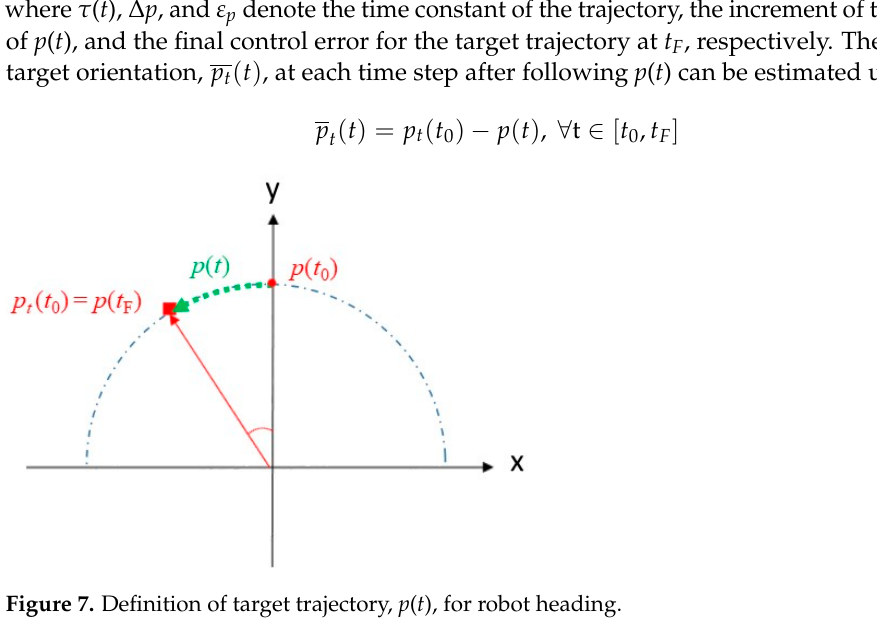
Figure 7. Definition of target trajectory, p ( t ), for robot heading.